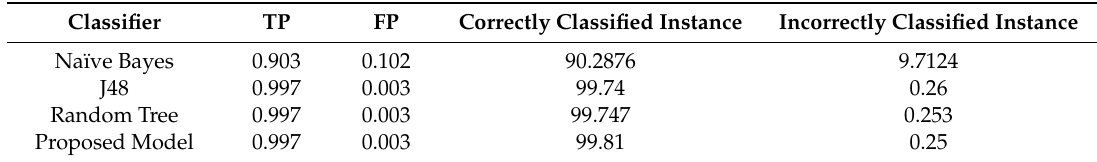
Table 1. Comparison of four classifiers.